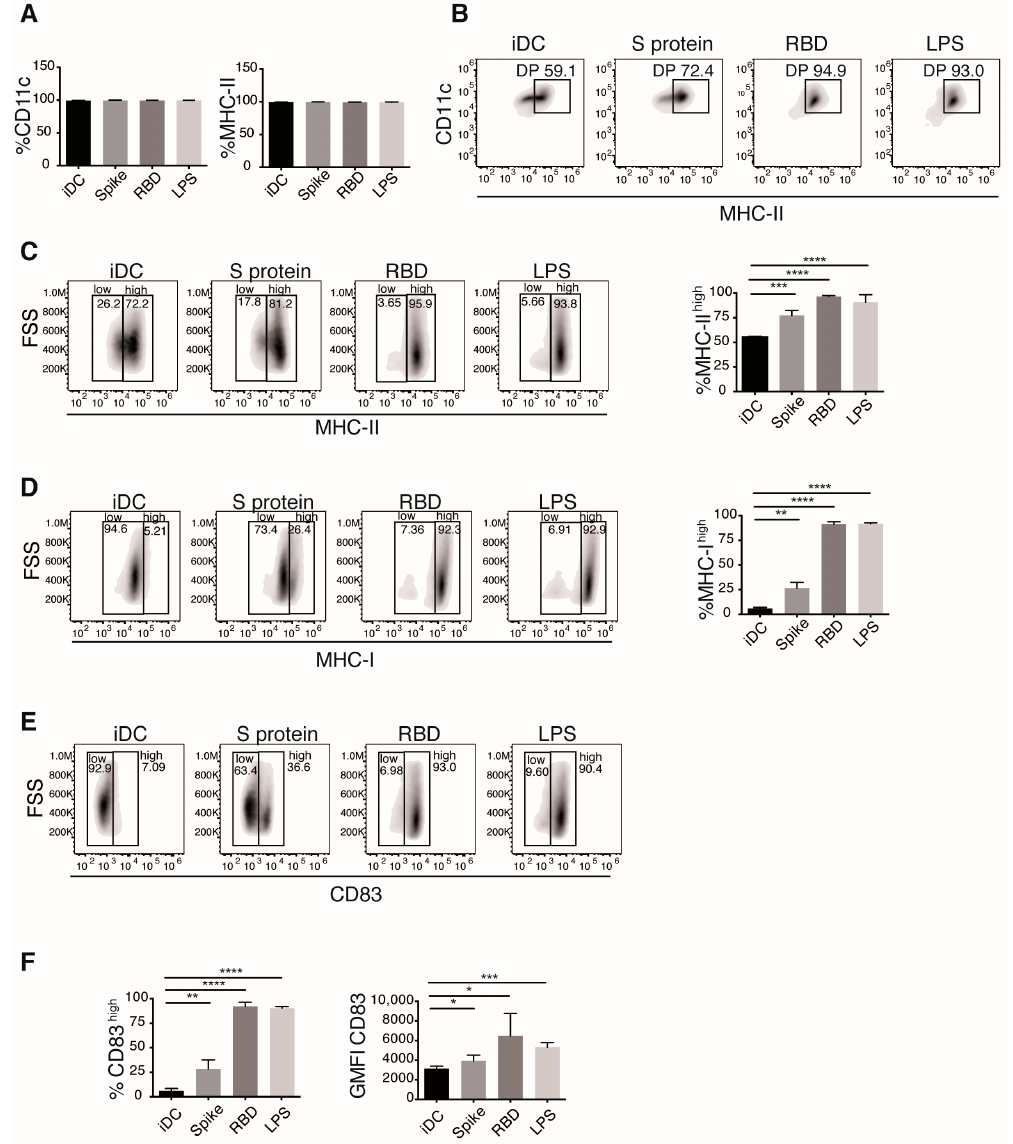
Figure 1. Spike protein and the RBD of SARS-CoV-2 promote maturation of iDCs. Cells were stimulated with Spike